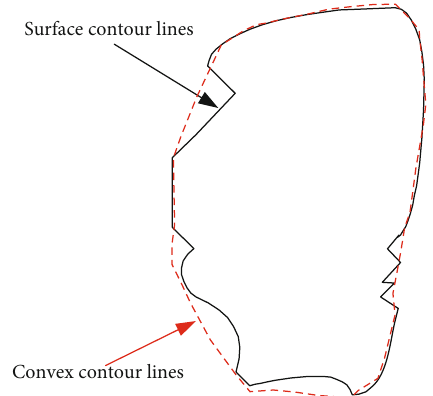
Surface contour lines